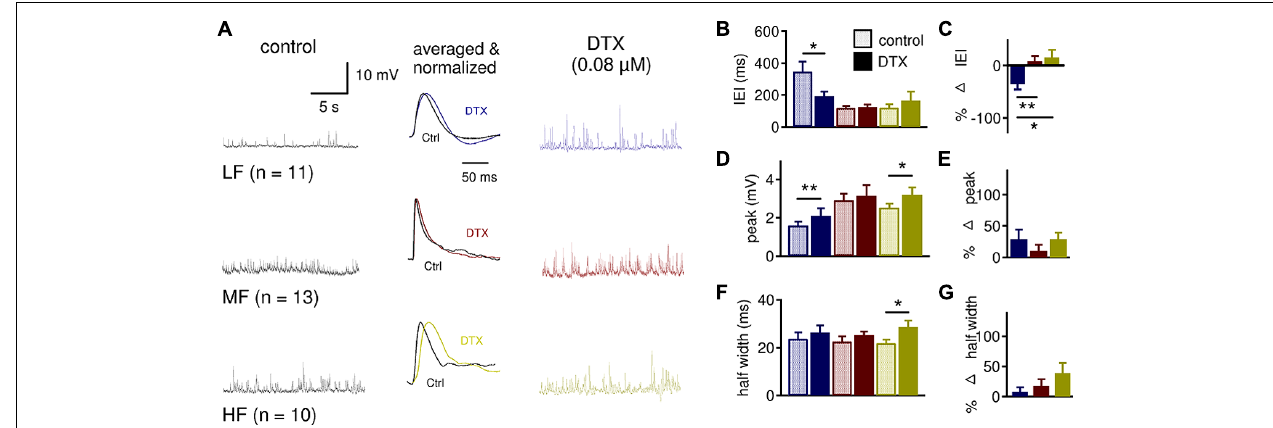
FIGURE 7 | LTK currents strongly regulate sIPSP frequency in LF neurons and sIPSP shape in HF neurons. (A) Sample sIPSP recordings before (dark traces) and after (color traces) bath application of DTX (0.08 μ M) in LF ( n = 11), MF ( n = 13) and HF ( n = 10) NL neurons. See Figure 6A for legend. (B) The IEI significantly decreased in LF (control: 347.2 ± 63.1 ms, DTX: 192.3 ± 30.2 ms) but not MF (control: 120.0 ± 11.0 ms, DTX: 119.4 ± 12.8 ms) and HF (control: 129.4 ± 24.8 ms, DTX: 164.5 ± 57.2 ms) neurons after DTX. (C) The percent decrease in IEI of sIPSPs is significantly greater in LF ( − 35.3 ± 10.4%) neurons compared to MF (8.1 ± 9.8%) and HF (15.5 ± 14.4%) neurons. (D) There is a significant increase in sIPSP peak